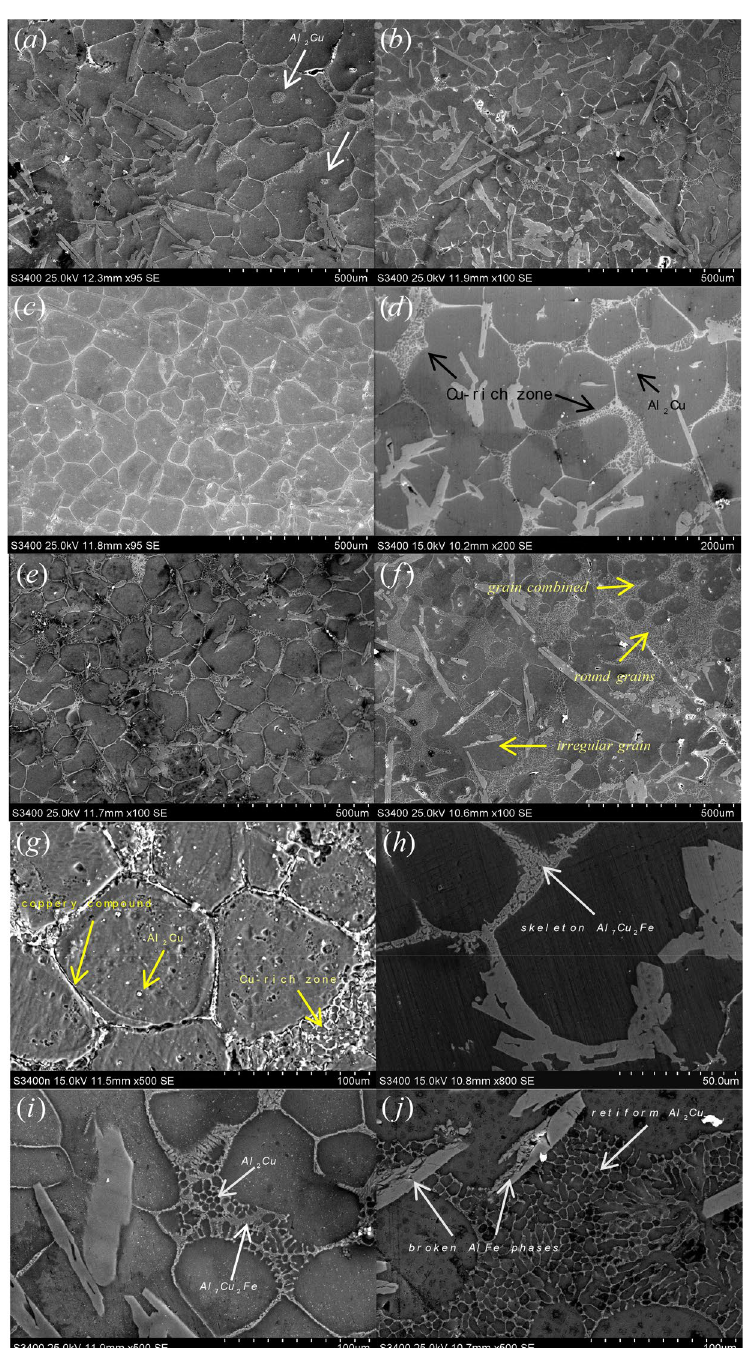
Figure 6. Microstructure of Al–Fe–Cu alloy semisolid heating under different temperatures and times (unetched). ( a ) Holding 30 min at 610 °C, there are many circular Al 2 Cu particles within the grains (from the liquid pools in the intra-grains) and thin the grain boundaries as well thick the re-solidified zones including Al 2 Cu and Al 7 Cu 2 Fe mixtures (Cu-rich zone); ( b ) holding 30 min at 630 °C; ( c ) holding 30 min at 640 °C, the rounded Al 2 Cu granules within the grains reduce and diminish, the grain boundaries broaden and the reticulations increase and the pinnates decrease in the re-solidified zones; ( d ) holding 5 min at 630 °C, there are retiform Cu-rich zone between the grains and rounded white Al 2 Cu particles in the intra-grains; ( e ) holding 15 min at 630 °C, the distribution of shorter and sparser AlFe phases results in more circular grains; ( f ) holding 60 min at 630 °C, upper right, the grains are completely surrounded by the liquid, forming rounded grains and occurring grains join. Lower left, the liquid is separated by AlFe phases, resulting in irregular grains; ( g ) holding 5 min at 640 °C (Keller etched), the white Al 2 Cu granules in the intra-grains, the white coppery compounds boundaries and retiform re-solidified zone between the grains; ( h ) holding 30 min at 610 °C, the skeleton Al 7 Cu 2 Fe etc. cupriferous compounds on the grain boundary; ( i ) holding for 20 min at 630 °C, the grain boundaries with skeleton cupriferous intermetallic and the re-solidified zone with the retiform Al 2 Cu and the penniform Al 7 Cu 2 Fe mixture; ( j ) holding 60 min at 640 °C, the retiform Al 2 Cu mixture on the re-solidified zone between the grains and AlFe phase, and showed broken AlFe